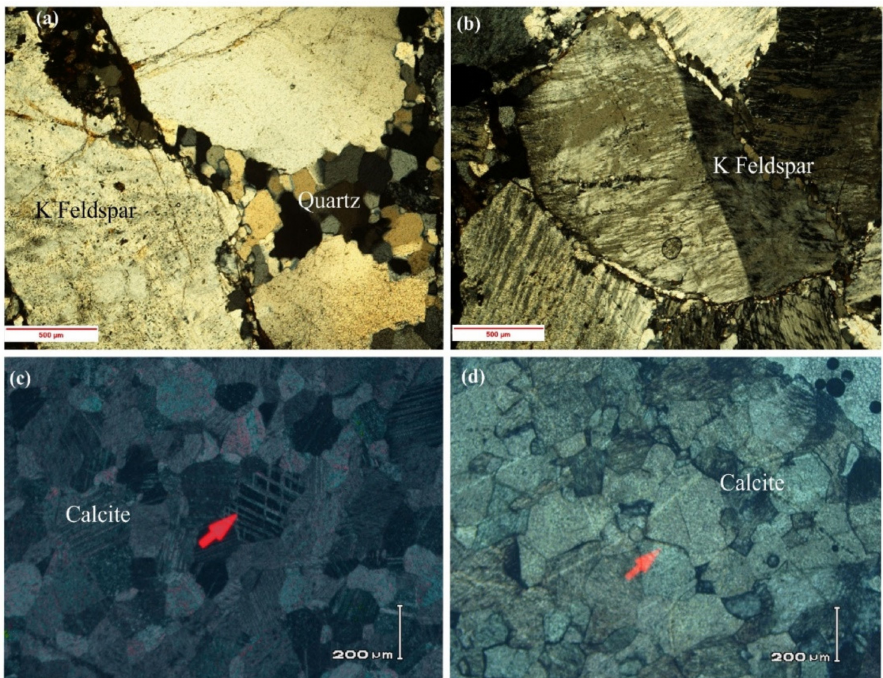
Figure 13. Petrographic and textural examination and characterization results of the sample rocks. The coordinates of samples: ( a ) P1: 72 ◦ 20 (cid:48) 31 (cid:48)(cid:48) E, 34 ◦ 20 (cid:48) 26 (cid:48)(cid:48) N; ( b ) P5: 72 ◦ 24 (cid:48) 17 (cid:48)(cid:48) E, 34 ◦ 17 (cid:48) 51 (cid:48)(cid:48) N; ( c ) P7: 72 ◦ 28 (cid:48) 10 (cid:48)(cid:48) E, 34 ◦ 17 (cid:48) 37 (cid:48)(cid:48) N; and ( d ) P6: 72 ◦ 28 (cid:48) 7 (cid:48)(cid:48) E, 34 ◦ 17 (cid:48) 36 (cid:48)(cid:48)